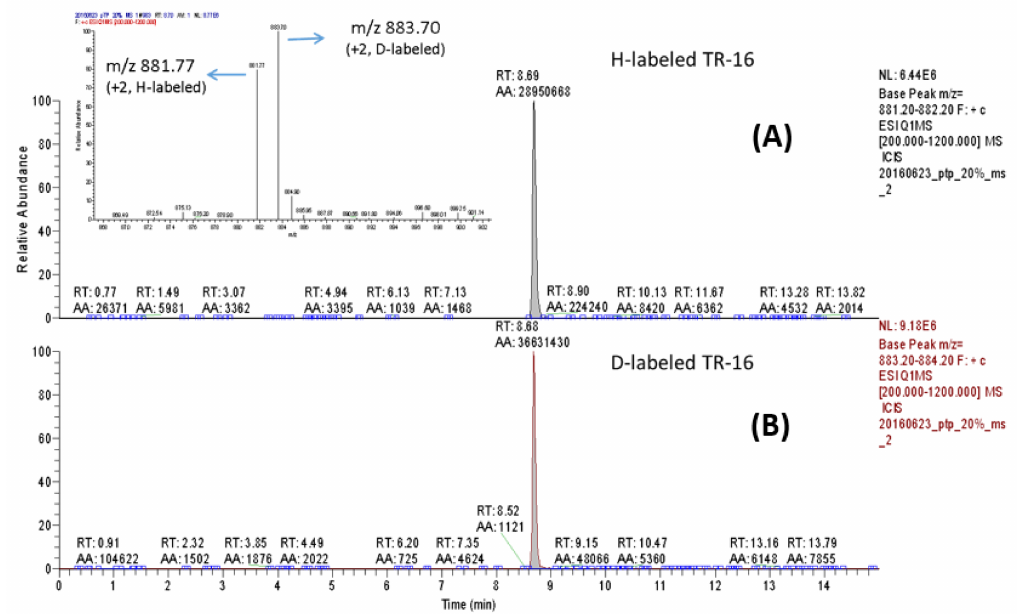
Figure 2. The representative LC-MS (selective ion chromatogram (SIC) of TSQ) chromatograms for quantitative analysis of site-specific phosphorylation: ( A ) the SIC of nonphosphorylated TQTPPVSPAPQPTEER (TR-16) labeled with light atom (H) dimethylation and ( B ) the SIC of D-labeled TR-16 was contributed by nonphosphorylated and dephosphorylated TQTPPVSPAPQPTEER derived